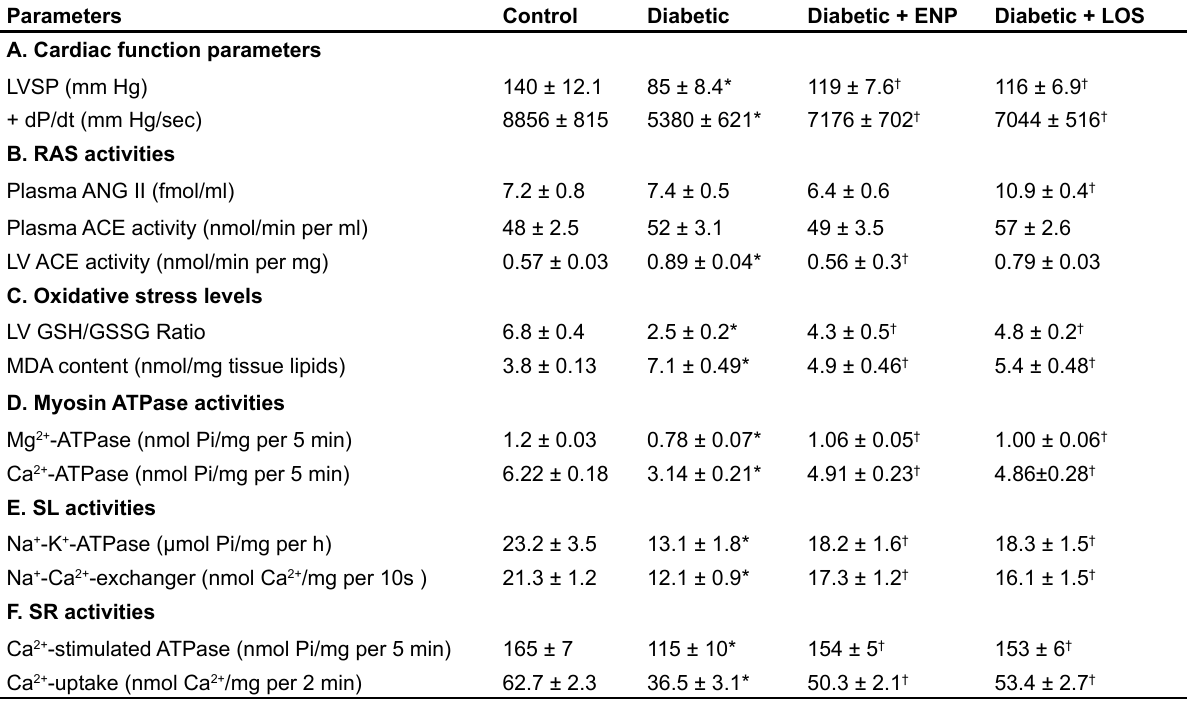
Table 7. Cardiac performance, status of RAS, oxidative stress and subcellular activities in 8 weeks diabetic rats with or without ENP and LOS treatments